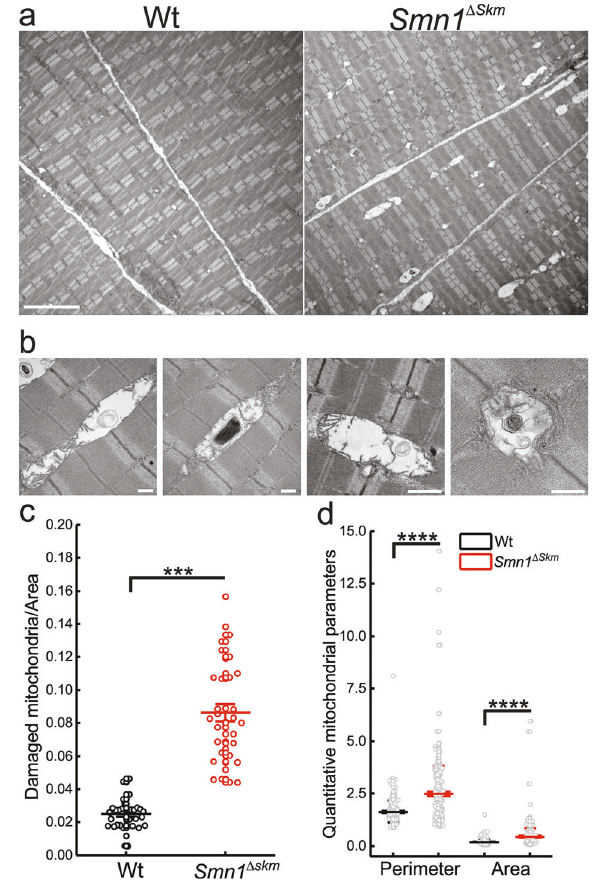
Fig. 3 Skeletal muscle mitochondria of Smn1 Δ Skm mice show ultrastructural abnormalities. a Representative electron micro- graphs of mitochondria from TA muscles of the indicated genotypes. Scale bar: 5 μ m. b Representative high magni fi cation of abnormal mitochondria in TA muscle of Smn1 Δ Skm mice. Scale bar: 0.5 μ m. c Box-dots plots of the number of damaged mitochondria per area of Wt and Smn1 Δ Skm TA muscles. The error bars indicate SEM; *** p = 2.8E-12. d Morphometric quanti fi cation of the area and perimeter of mitochondria from the different genotypes. >200 mitochondria from Wt and Smn1 Δ Skm mice ( n = 3) were analyzed. The error bars indicate SEM; **** p ≤